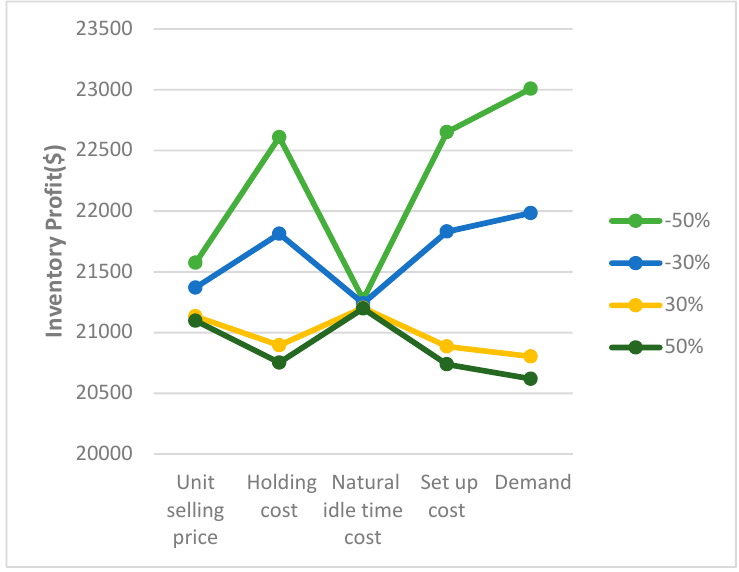
Figure 6. Graphical illustration of sensitivity